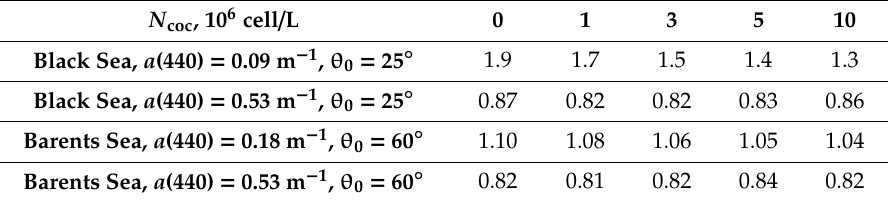
Table 4. The changes in the ratio ρ (490) / ρ (550) depending on the N coc